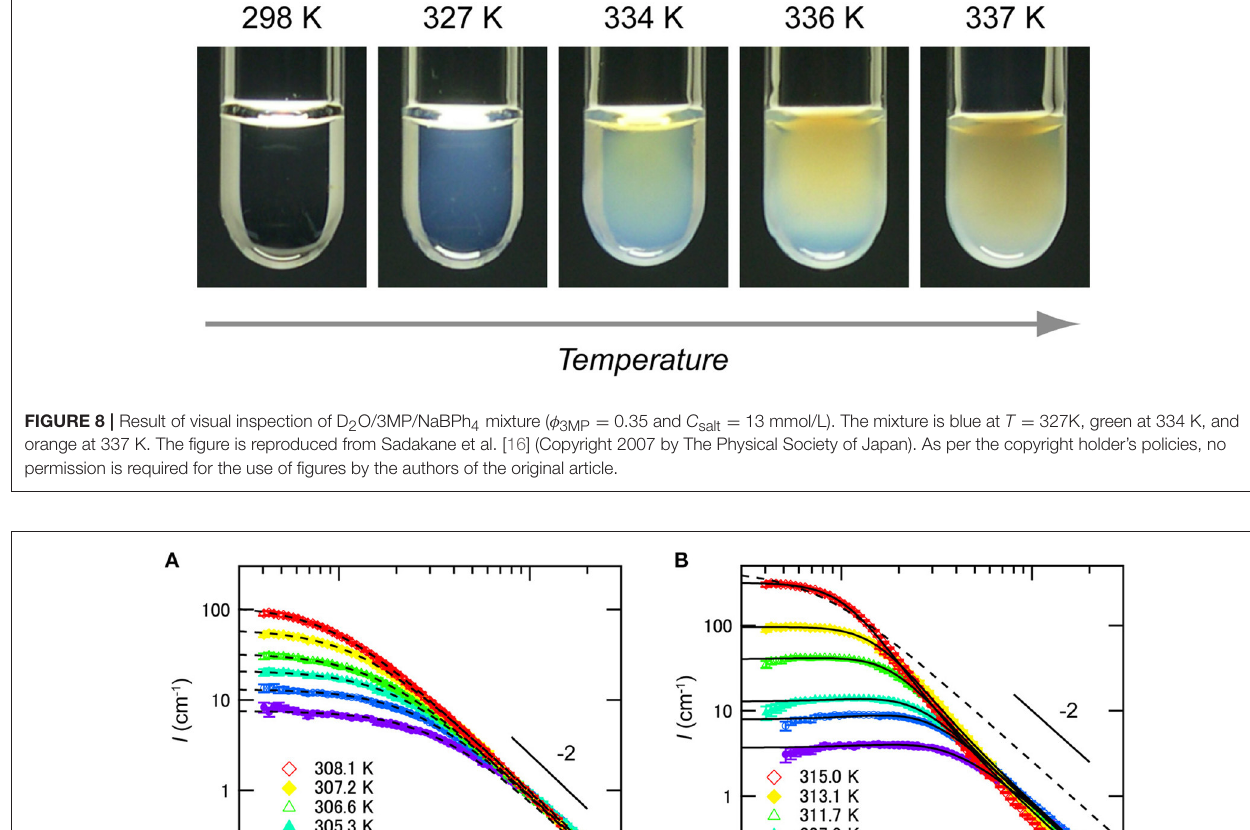
D 2 O/3MP/NaBPh 4 ( φ 3MP = 0.35 and C salt = 6